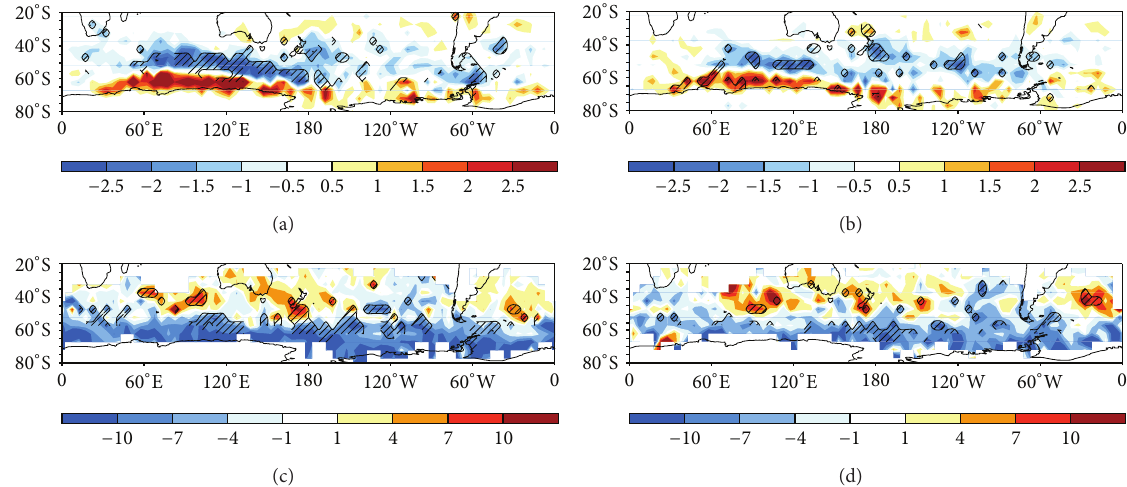
Figure 5: SH Winter (JAS) AAO positive-AAO negative cyclone track frequency composite for (a) NCEP1 5801, (b) like “a” but for ERA40 5801. Units: number of cyclones. Hatched areas are significant at 90% for 2-tailed 𝑡 -test. (c) SH Winter (JAS) IOD positive-IOD negative cyclone track intensity composite for NCEP1 5801, (d) like “c” but for ERA40 5801. Units: hPa. Hatched areas are significant at 90% for 2-tailed 𝑡